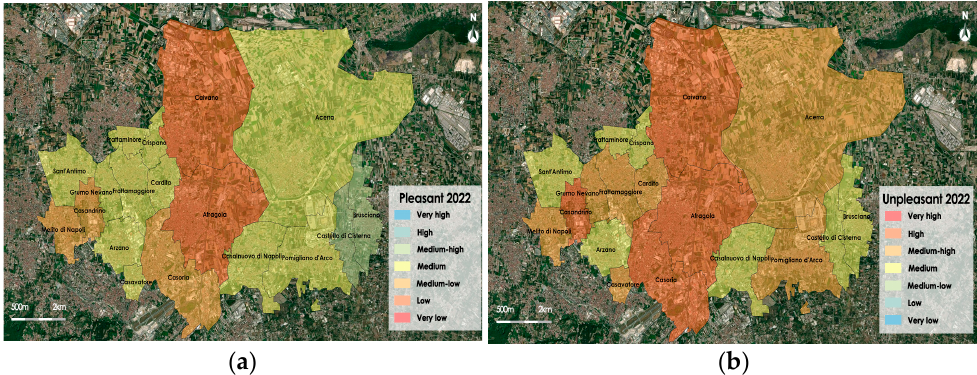
Figure 8. Pleasant and unpleasant emotion relevance thematic maps in 2022. ( a ) Pleasant emotion relevance. ( b ) Unpleasant emotion